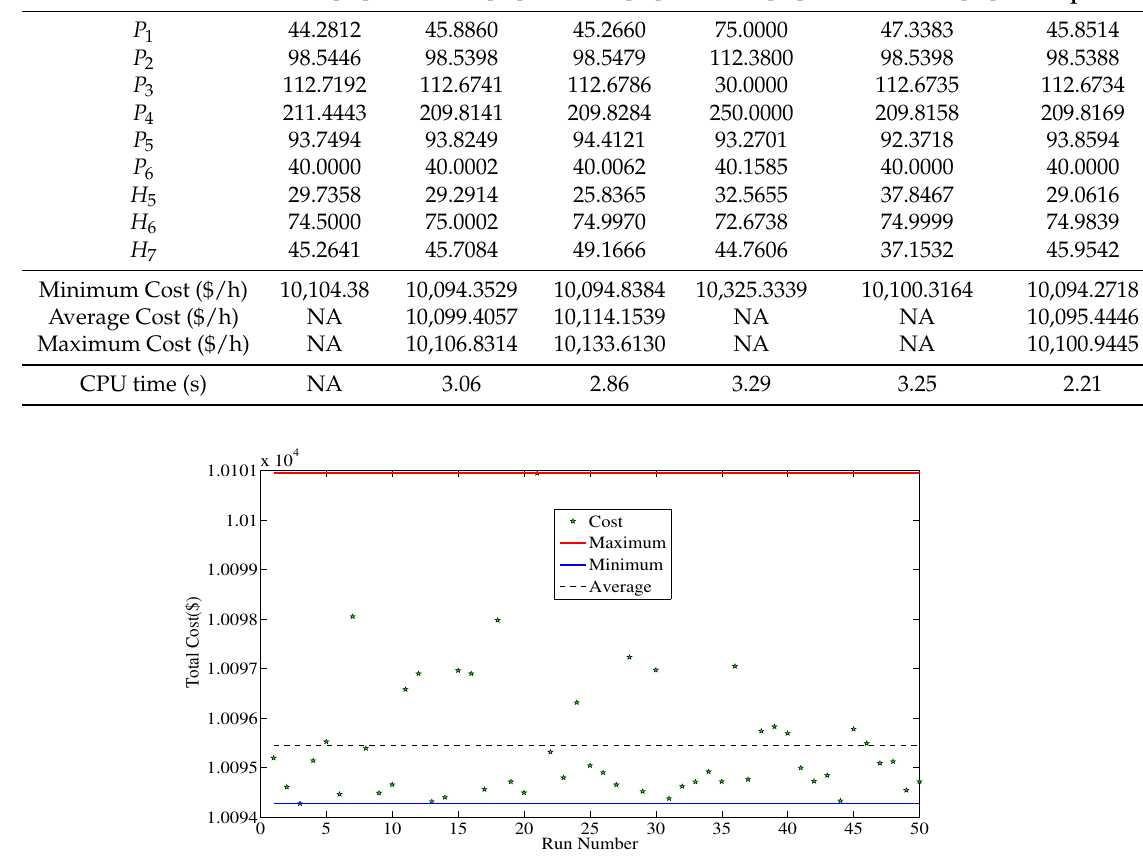
Figure 4. Distribution of total costs for 50 independent runs for 7-unit test system (Case I).